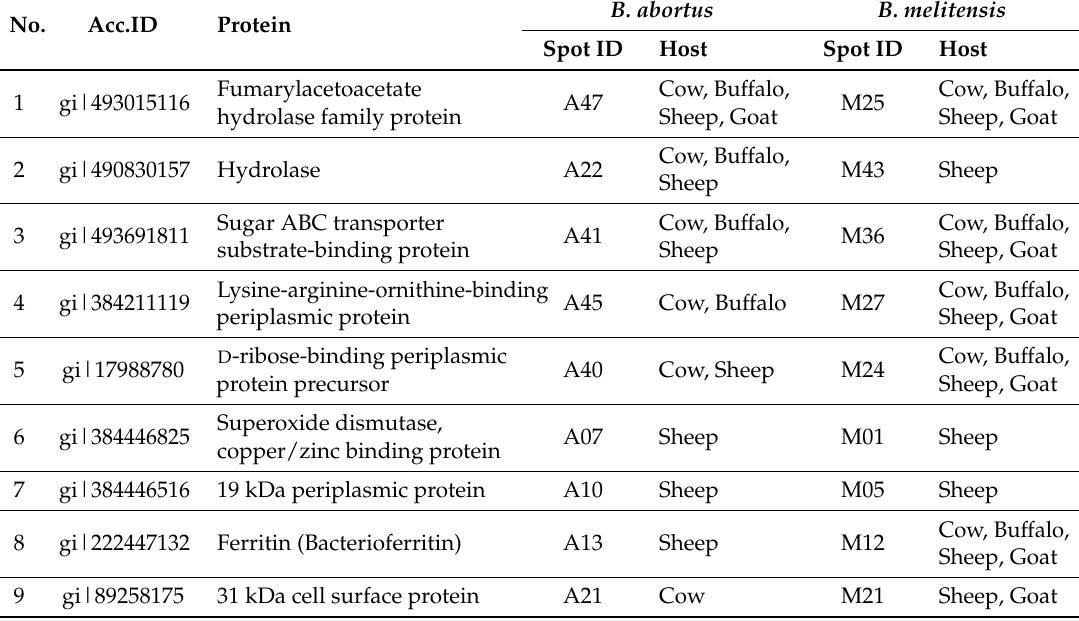
Table 3. Cross-reactive proteins identified by immunoblotting in the B. abortus and B. melitensis field strains using sera from different naturally infected host species (A: B. abortus ; M: B. melitensis ); Acc.ID: accession number at